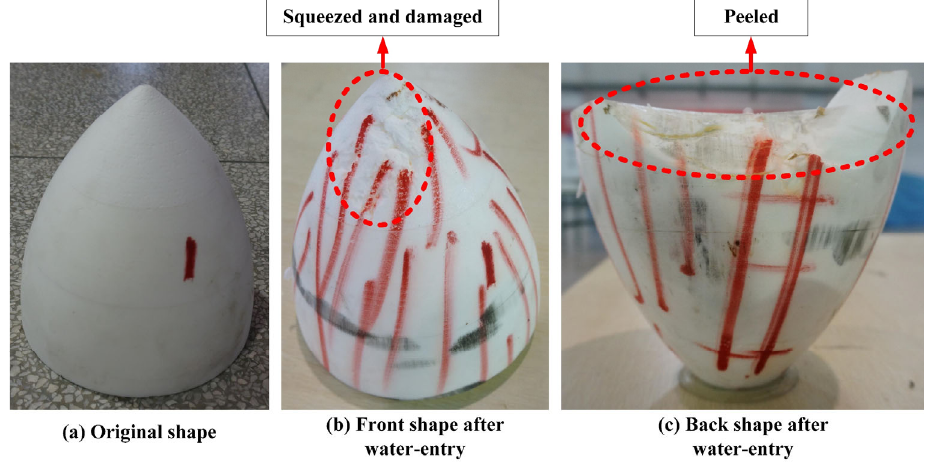
Figure 14. Comparison of No. 1 head cap before and after water entry.